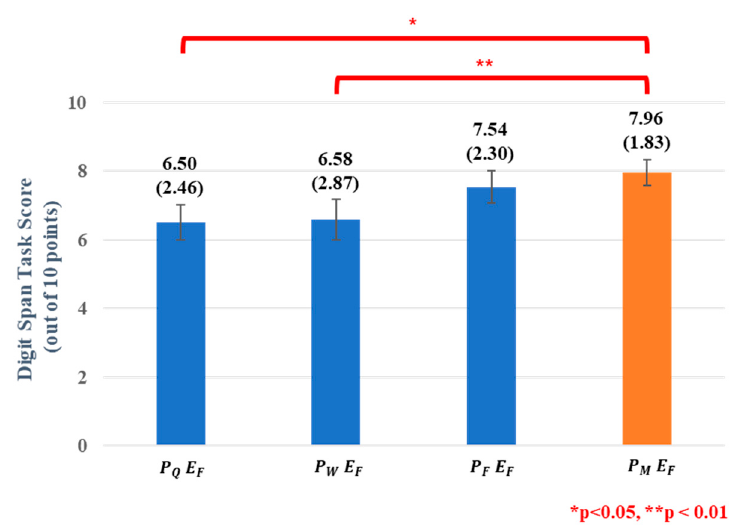
with auditory Figure 8. The mean and standard deviation of Digit span task scores for each experimental condition with auditory pre-stimulation.